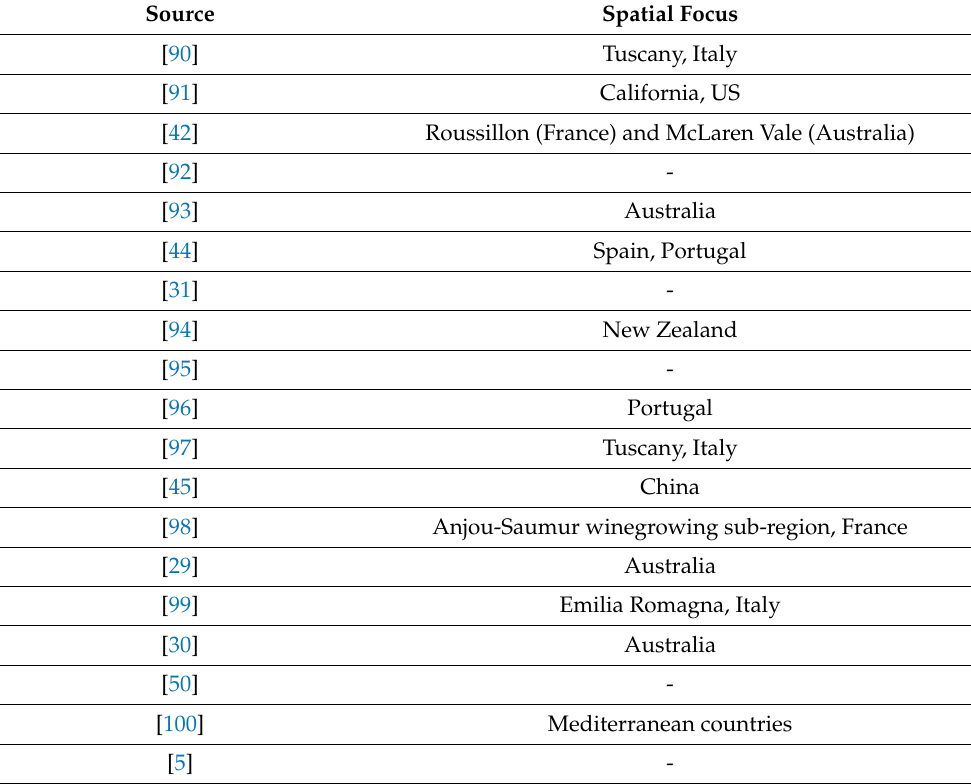
Table 1. Collected literature to define the adaptation